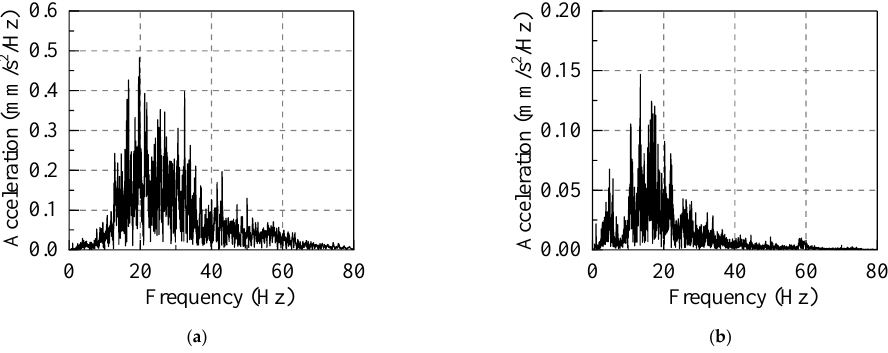
mainly low − frequency vibration with frequencies in the range of 5 − 40 Hz. Therefore, this frequency interval is defined as the prediction and analysis frequency band. In the vibration prediction, the acceleration for the frequency interval 5–40 Hz will be mainly calculated.